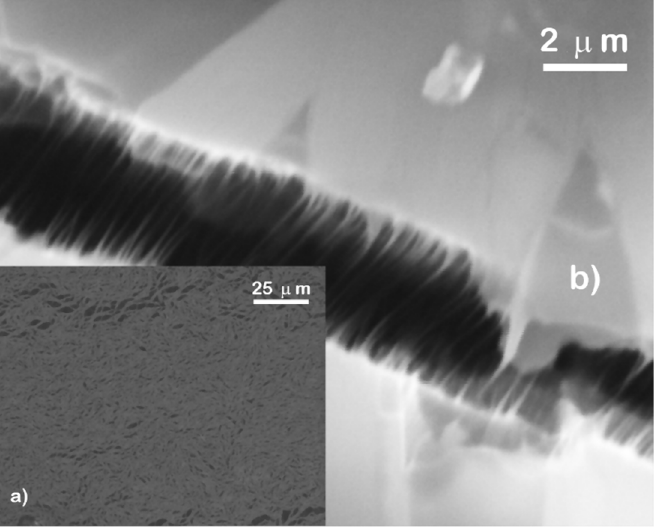
Figure 1. SEM images for ( a ) high continuity on SWCNT uncracked film and ( b ) low continuity on SWCNT cracked film.